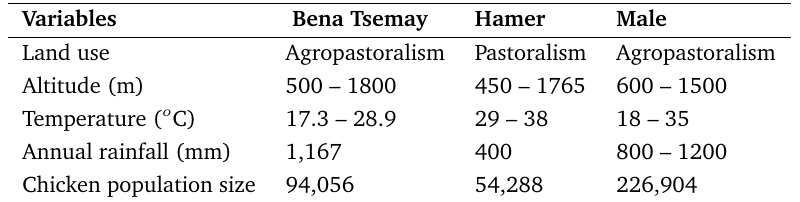
Table 1. Land use, climatic factors and chicken population size of the three studied districts. Data from Hidosa et al (2020); Hidosa and Tesfaye (2018); Gezahegn and Bamud (2018); Derib